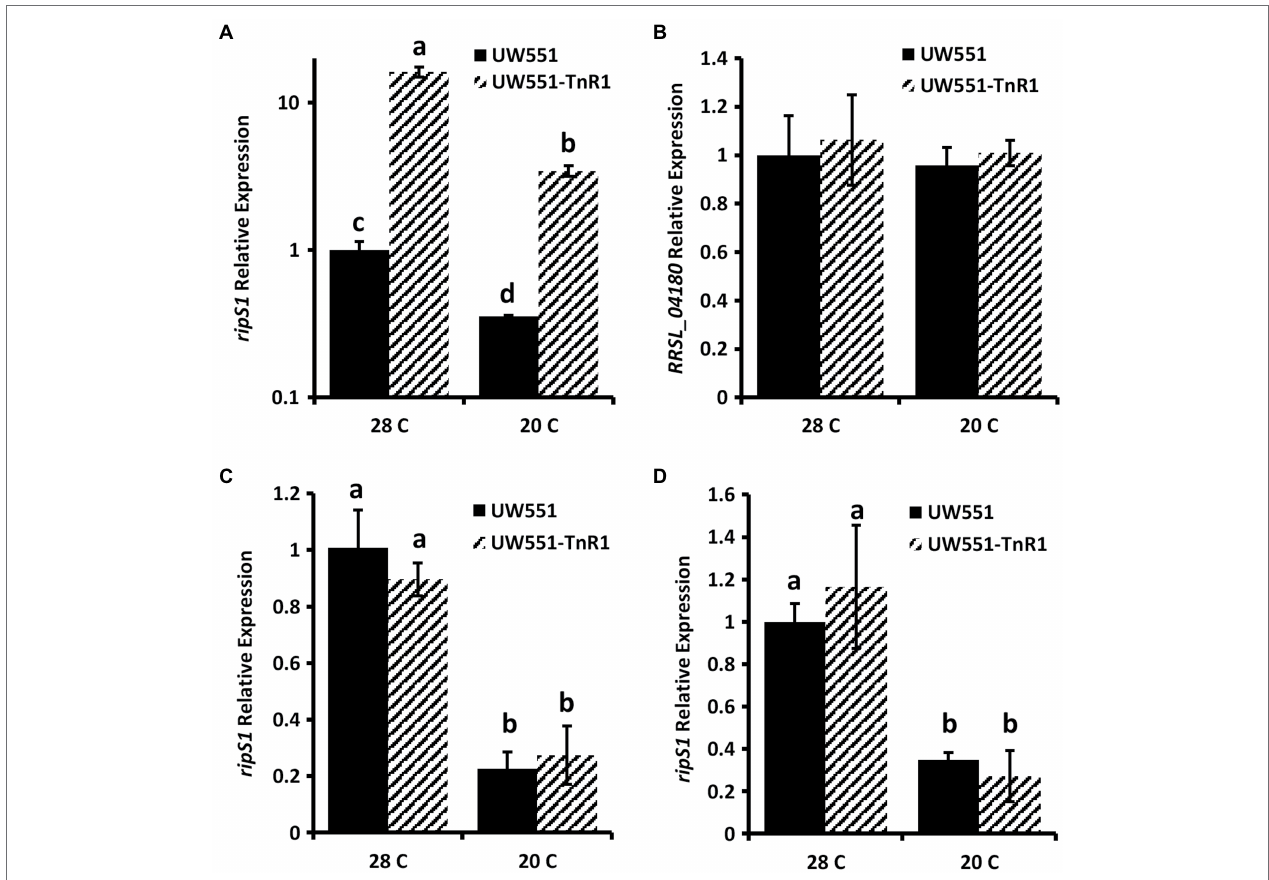
FIGURE 2 | Relative mRNA abundance in wild-type UW551 or transposon mutant UW551-TnR1 of ripS1 (A,C,D) or RRSL_04180 (B) . cDNA from RNA isolated from bacterial cells grown for 24 h in CPG medium (A,B) , in minimal medium (C) or using RNA from infected tomato seedlings (D) grown at 28 or 20 ° C served as template for quantitative real-time PCR (qRT-PCR) reactions. Three independent samples were collected for each strain-growth combination, and each sample was tested in triplicate. Values represent average of all samples and error bars represent SD. Samples with different letters are significantly different ( p < 0.05, Student’s t -test, all